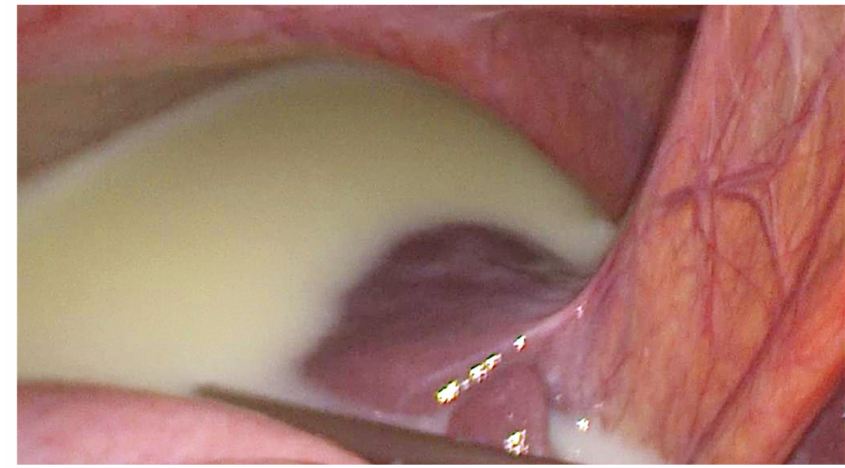
Figure 3. Intraoperative photography where chyloperitoneum is